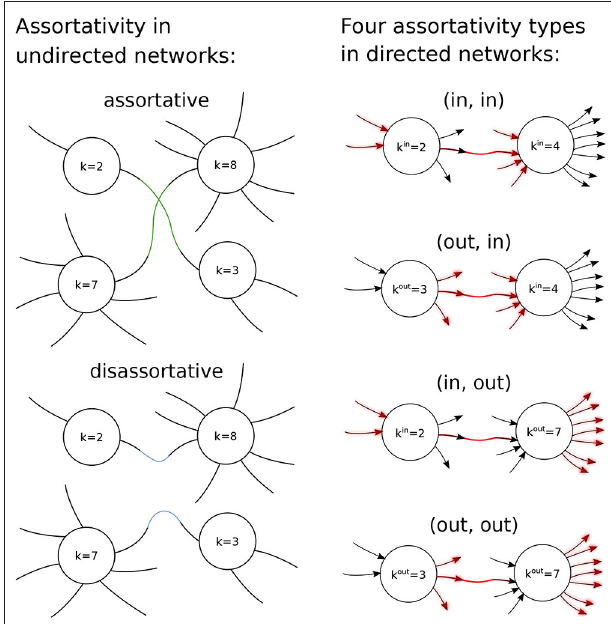
FIGURE 6 | Assortativity in undirected and directed networks. An undirected network (left) is assortative if high degree nodes are more likely to be connected to high degree nodes, and low to low, than by chance (top left). Such a network is disassortative if the opposite occurs (bottom left). (Here, the degree of a node is given by k .) In directed networks (right) there are four possible kinds of assortativity. The probability of a connection (red) depends on the number of red shaded links of the sending (left) and receiving (right) node. (Here, either the in-degree, k in , or out-degree, k out , of a node is the relevant